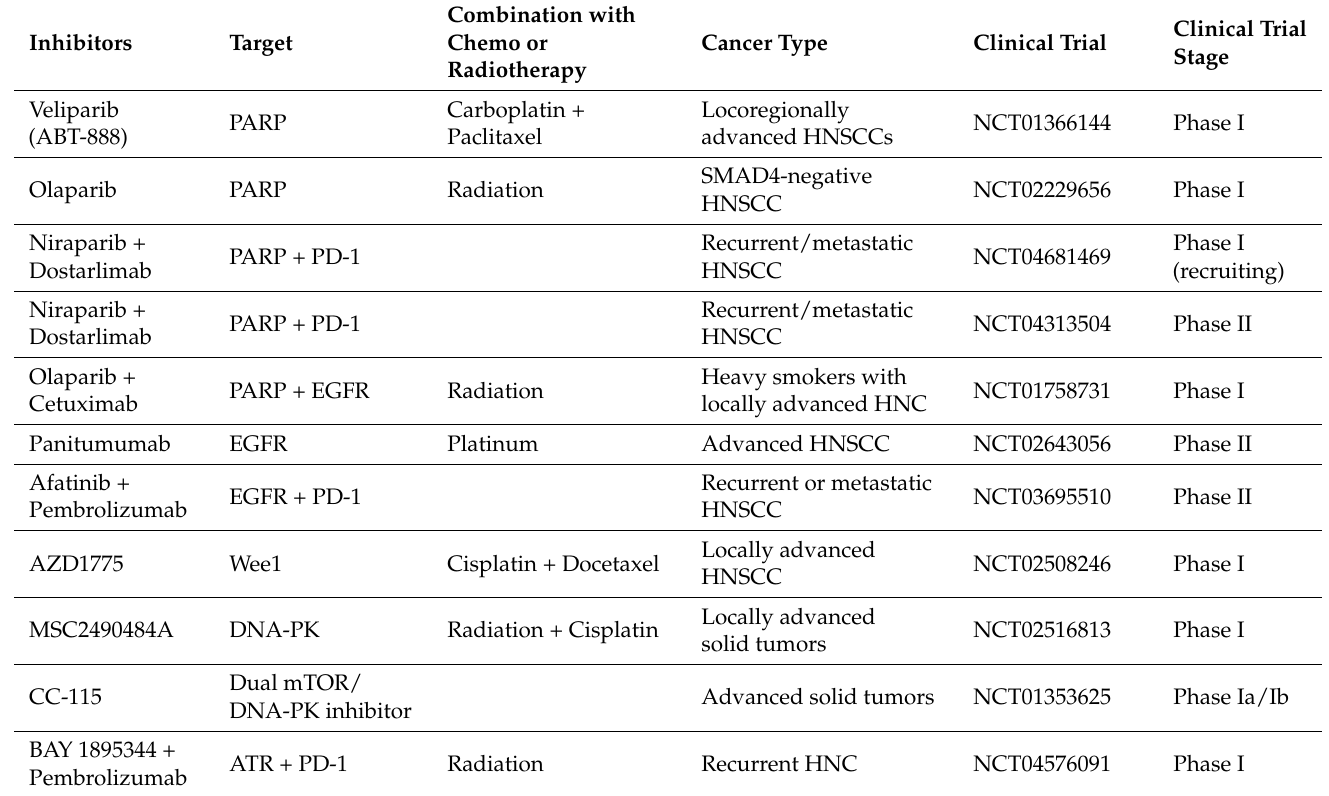
Table 2. List of DDR inhibitors currently being tested in clinical